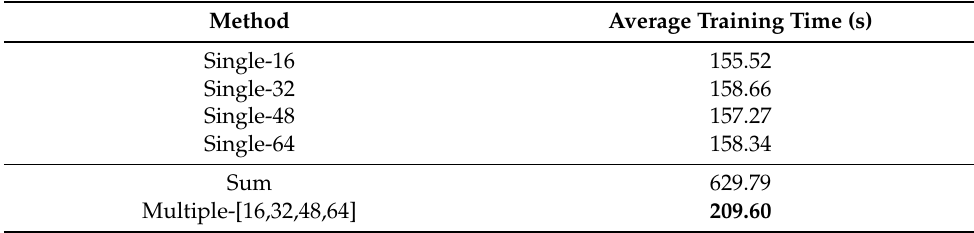
Table 3. Performance of training efficiency among the multi-lengths and the single-length hash codes.